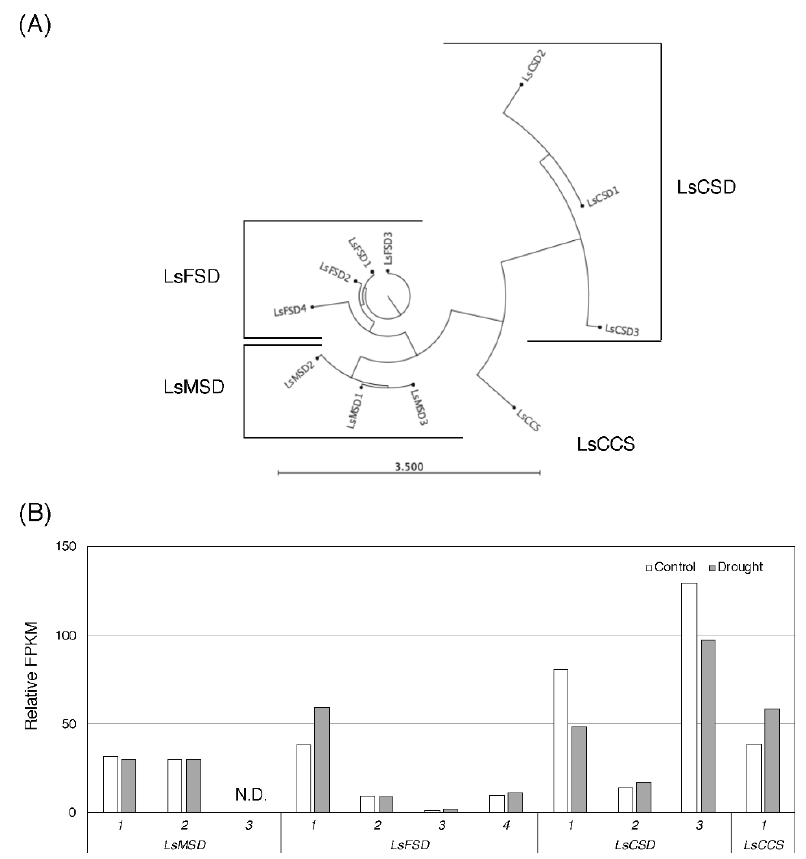
Figure 2. Phylogenetic tree of SOD and relative expression of SOD genes during dehydration in lettuce. The protein sequences of 11 SODs were obtained from a lettuce genome database ( Lactuca sativa v8.0 genome), and a phylogenetic tree was constructed ( A ). SODs were divided into four groups: Mn-SOD (LsMSD), Fe-SOD (LsFSD), Cu-Zn SOD (LsCSD), and Cu-SOD (LsCCS). The relative expression of SOD was compared via RNA-seq ( B ). The expression levels of SOD were evaluated with the fragments per kilobase per million reads (FPKM) between the control (white) and drought stress (gray). Each relative FPKM was calculated on the basis of the control treatment of LsFSD3 .